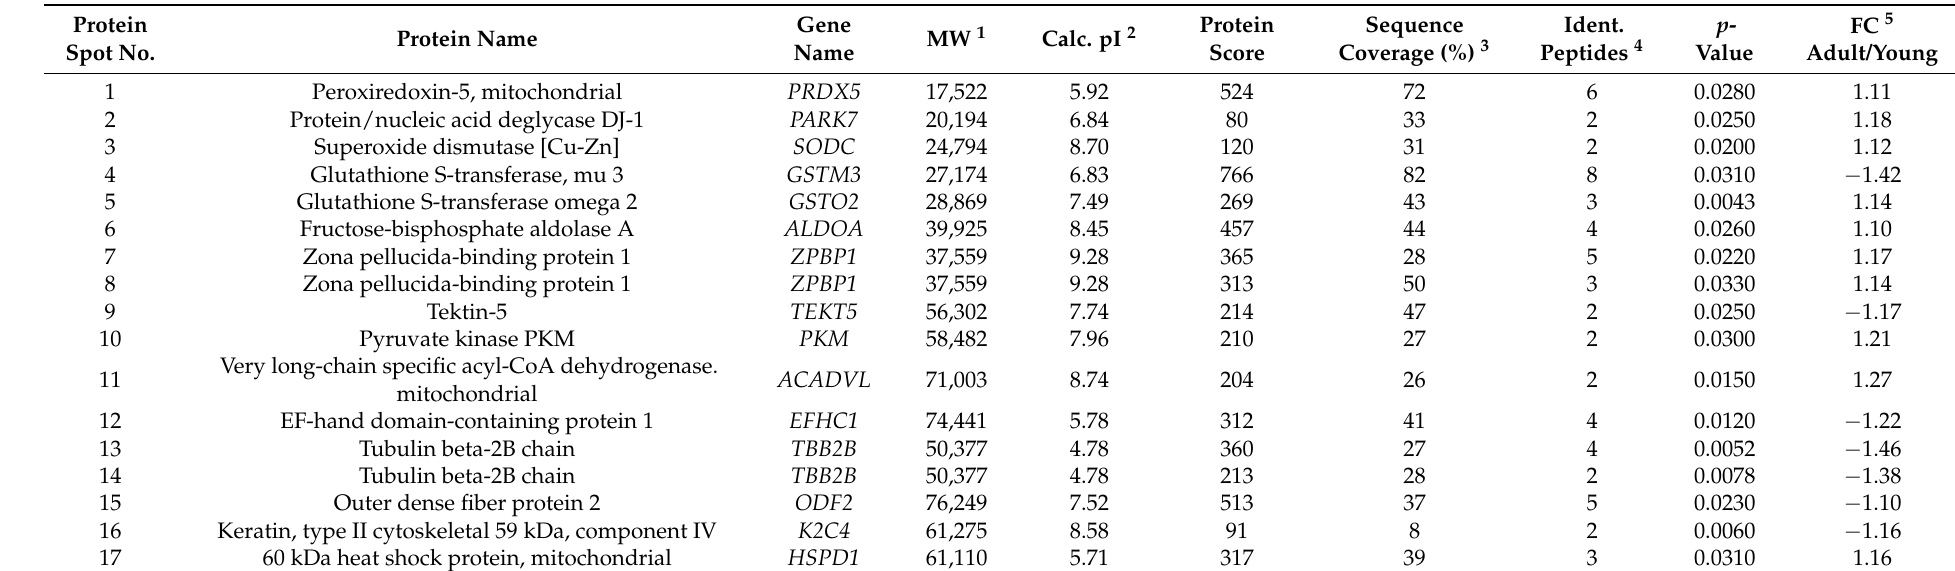
Table 2. Proteins changing in thawed spermatozoa of adult bulls in comparison to young bulls.